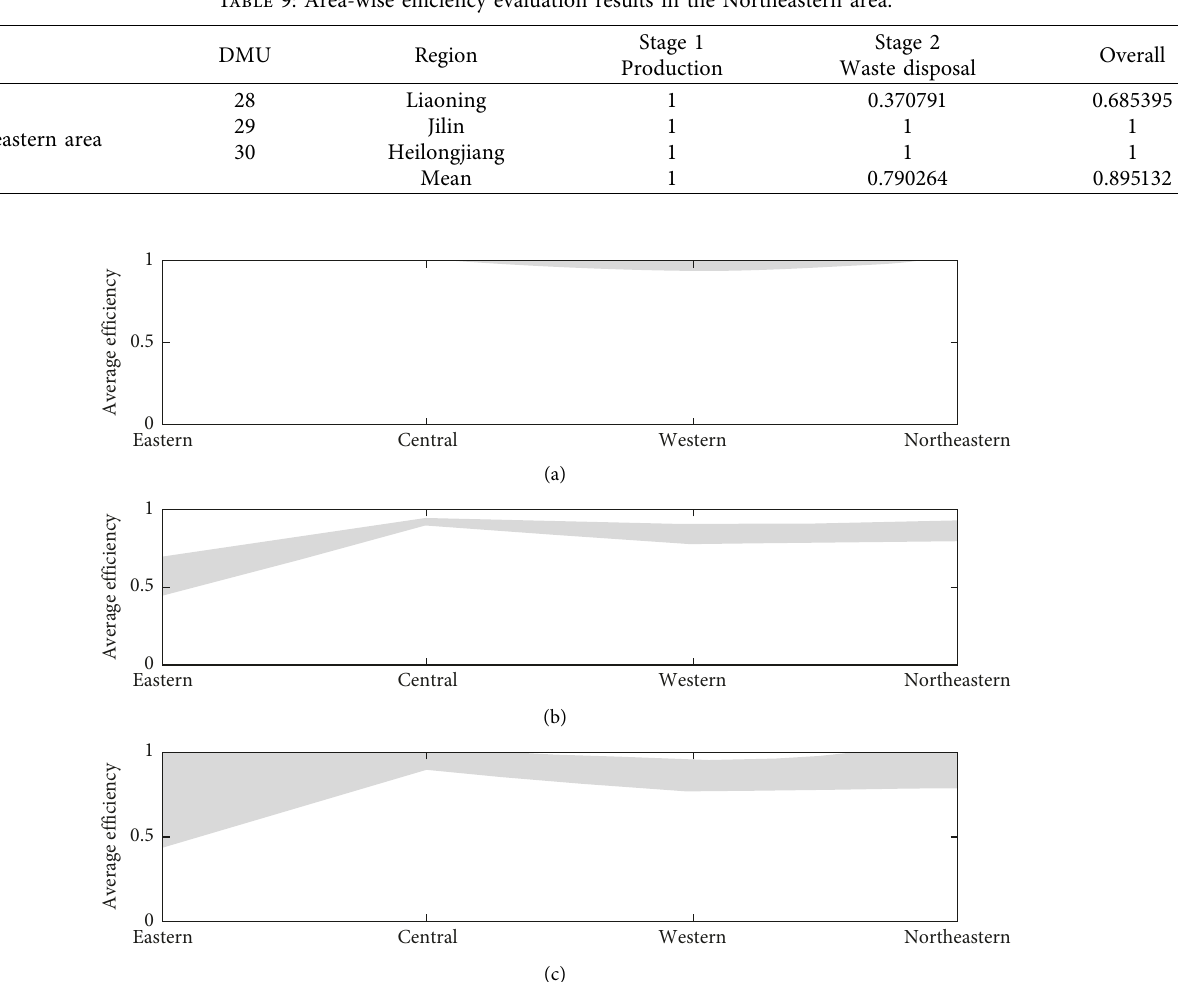
Table 9: Area-wise efficiency evaluation results in the Northeastern area.